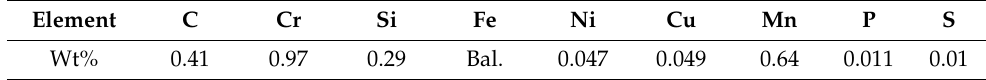
Table 1. Chemical composition of 40Cr (wt%).